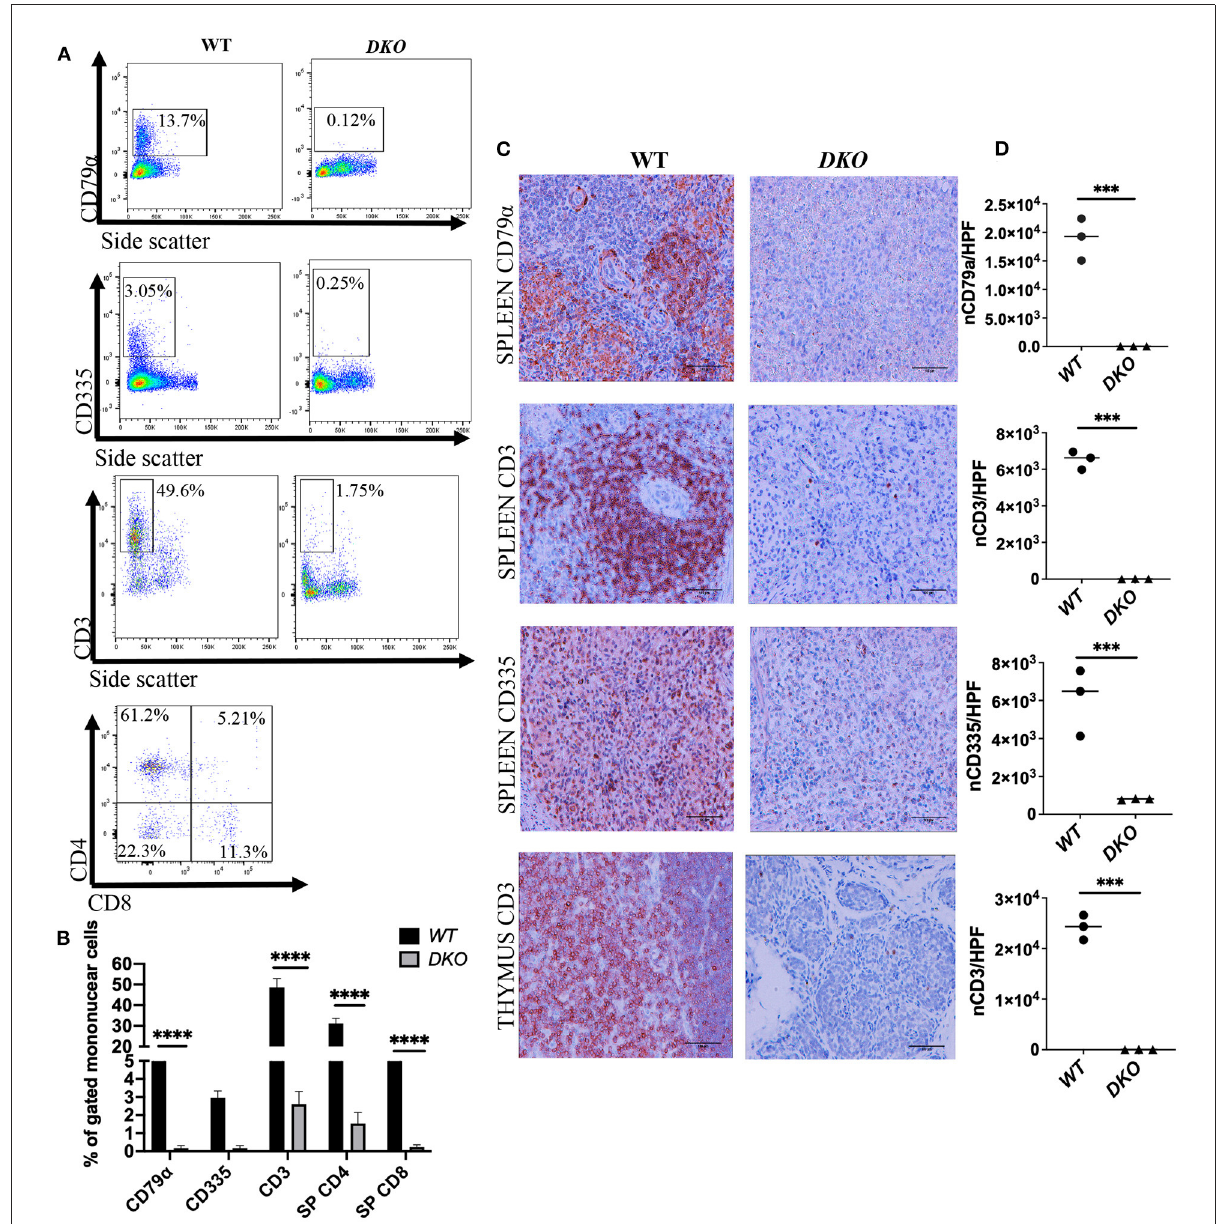
FIGURE2 Lymphoid cell analysis of peripheral blood and lymphoid tissue from immunodeficient DKO pigs. (A) Representative peripheral blood flow cytometry analysis showing CD79 α + cells, CD335 + cells, CD3 + CD4 + cells and CD3 + CD8 + cells for wild type ( n = 3) and DKO ( n = 4) pigs at 1 week of age. CD79 α + , CD335 + , CD3 + CD4 + , and CD3 + CD8 + are nearly undetectable in the peripheral blood of DKO pigs. (B) Histogram plot with bar of percentage from gated mononuclear cells for CD79 α + , CD335 + , CD3 + , CD3 + CD4 + and CD3 + CD8 + cells. Data represents mean, bars indicate standard deviation, and adjusted p values are represented for Tukey’s multiple comparisons tests one-way ANOVA with a significance value of 0.05. (C) Representative immunohistochemistry (40x magnification) showing spleen staining for CD79 α + (B cells), CD335 + (NK cells), and spleen and thymus staining for CD3 ( T -cells) for wild type ( n = 3) and DKO ( n = 3) pigs at 3 weeks of age. (D) scatter plot with individual values for the number of CD79 α + (spleen), CD335 + (spleen) and CD3 + (thymus and spleen) cells per high power field microscopy. CD79 α + , CD335 + , and CD3 + cells are nearly absent in the spleen, and CD3 + cells are nearly absent in the thymus of DKO pigs. Line represents the mean, and adjusted p values are represented for unpaired two-sample t -test with a significance value of P < 0.05. *** P < 0.001, **** P <